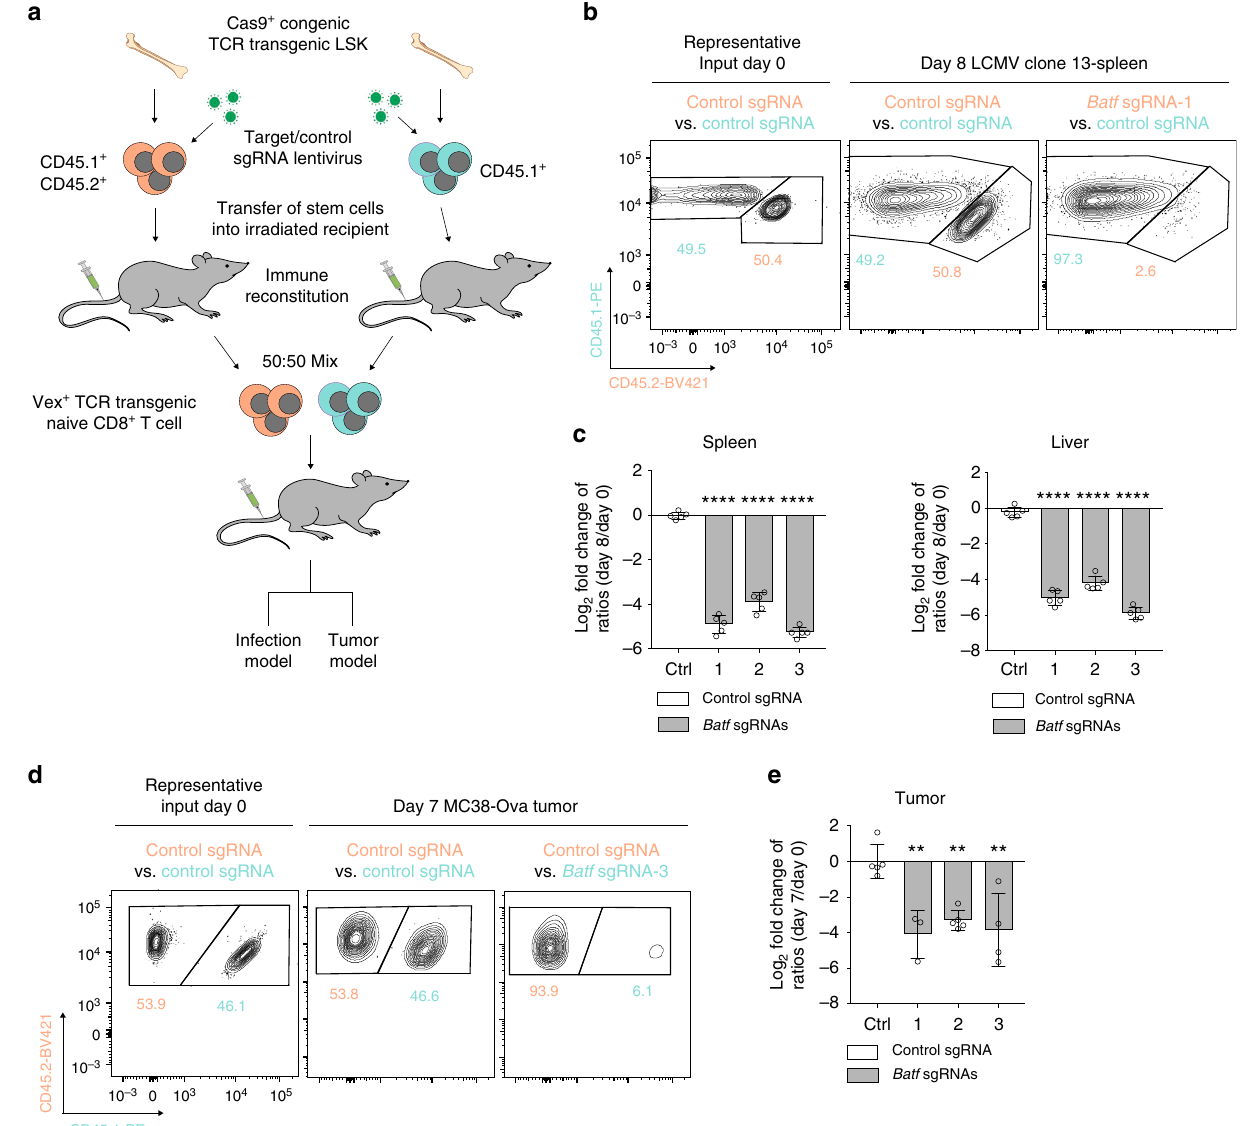
Fig. 3 CHIME recovers known positive regulators of effector CD8 + T cell responses. a Schematic of competitive assays. b Representative input and output fl ow cytometry plots of P14 T cells containing control sgRNA vs. control or Batf sgRNAs in the spleen 8 days post LCMV Clone 13 viral infection. c Quanti fi cation of P14 T cells containing control or Batf sgRNAs from the spleen (left) and liver (right) in (b) , normalizing the output fl ow cytometry plots to the input ratios at day 0 and log 2 transforming the data. d Representative output fl ow cytometry plots of OT-1 T cells containing control sgRNA vs. control or Batf sgRNAs in MC38-OVA tumors on day 7 post injection. e Quanti fi cation of OT-1 T cells containing control or Batf sgRNAs in (d) with normalization of the output fl ow cytometry plots to the input ratios at day 0 and log 2 transformation of the data. All experiments had three biological replicate animals per group and are representative of two independent experiments. Bar graphs represent mean and error bars represent standard deviation. Statistical signi fi cance was assessed among the replicate recipients of transferred T cells by one-way ANOVA ( c , e ) (* p < .05, ** p <